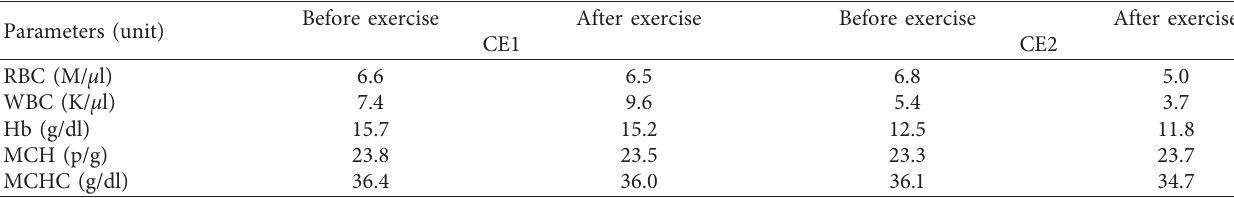
Table 5: Changes in hematological parameters after continuous exercise in dogs.